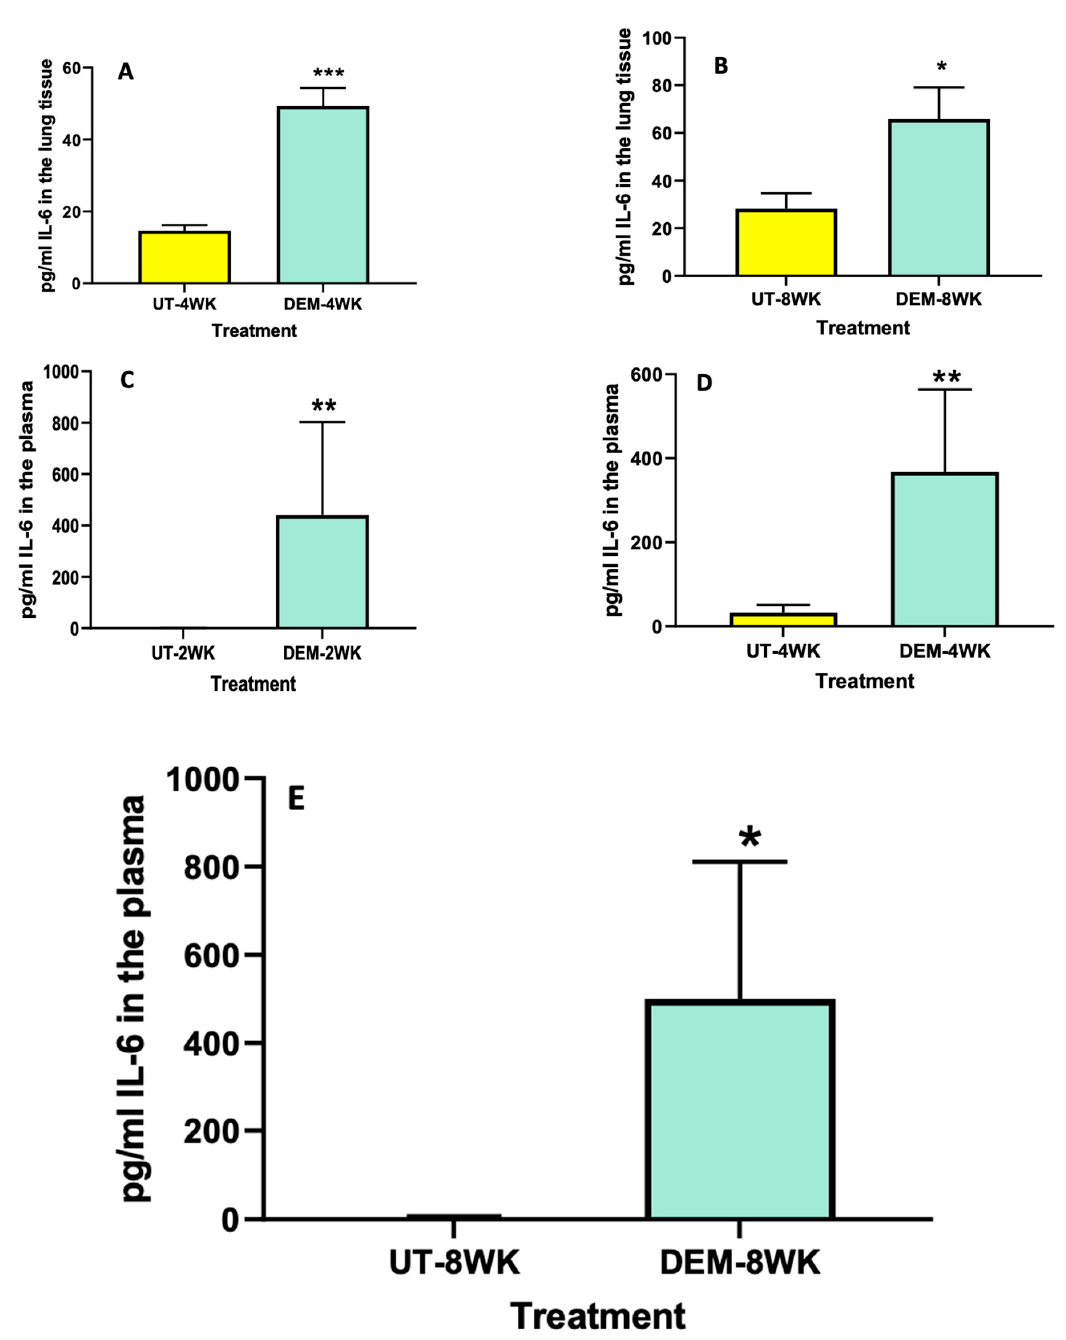
Figure 2. Measurement of IL-6 in the lung lysates and plasma of M. tb infected mice that were sham-treated or treated with DEM. IL-6 levels were measured in the lung lysates at 4 weeks ( A ) and 8 weeks ( B ) post-infection and in the plasma at 2 weeks ( C ), 4 weeks ( D ), and 8 weeks ( E ) post- M. tb infection. Statistical analysis was performed using GraphPad Prism software. Unpaired t tests were performed using Welsch correction. All values reported are representative of the mean values for each respective category and a p -value of <0.05 was considered significant. Any placement of an asterisk (*) denotes a direct comparison of the DEM-treated versus the untreated category. ** p -value < 0.005. When three asterisks are represented (***), a p -value below 0.0001 is implied. The sample size ( n ) includes six mice each in the untreated and DEM-treated groups.